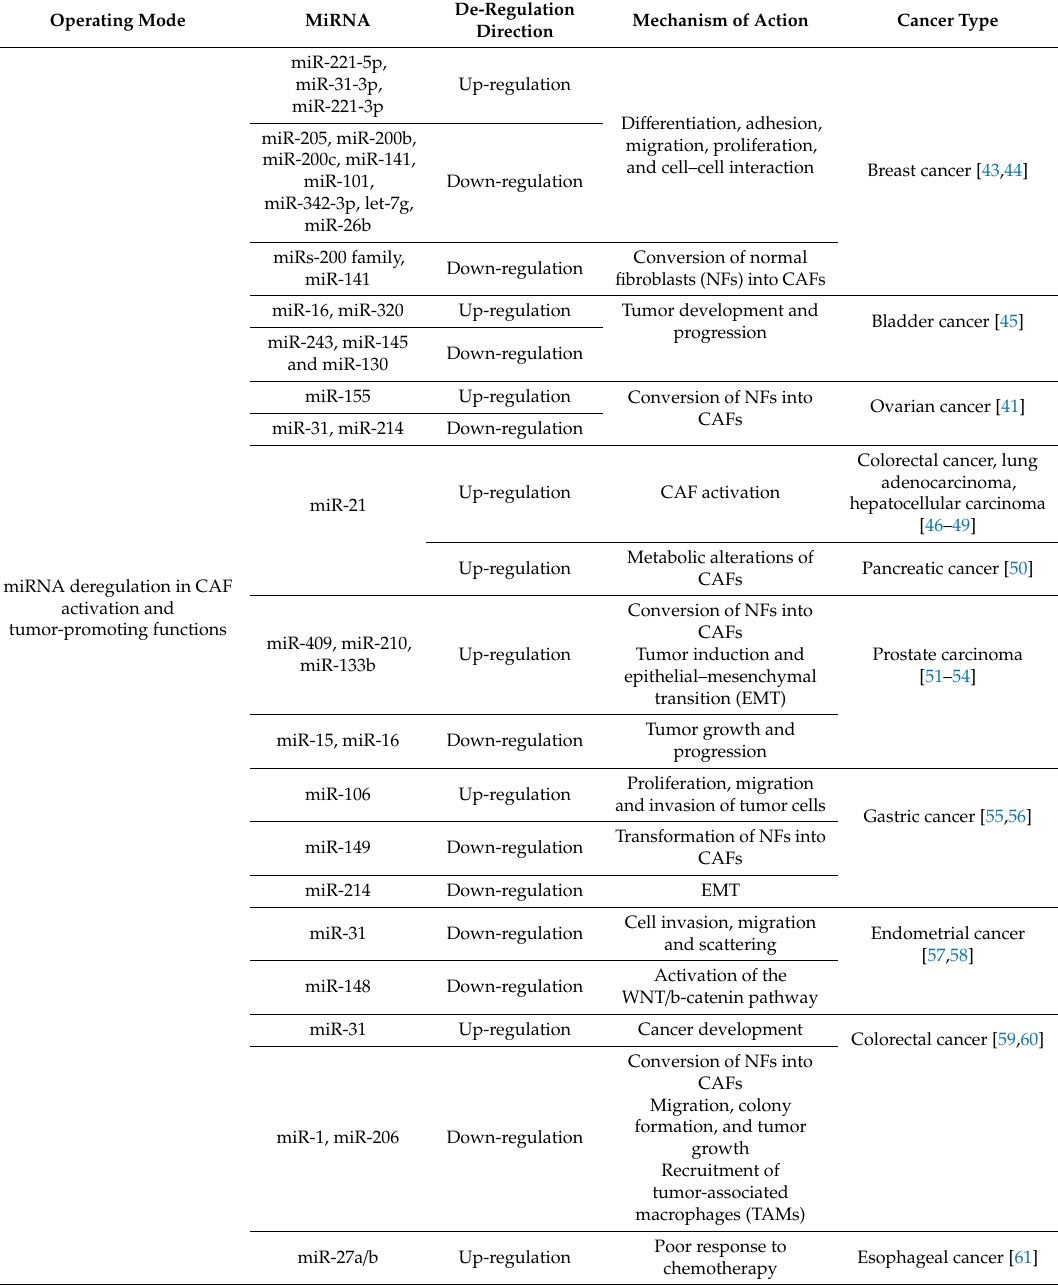
Table 1. Most relevant miRNAs implied in CAFs activation and their tumor prompting